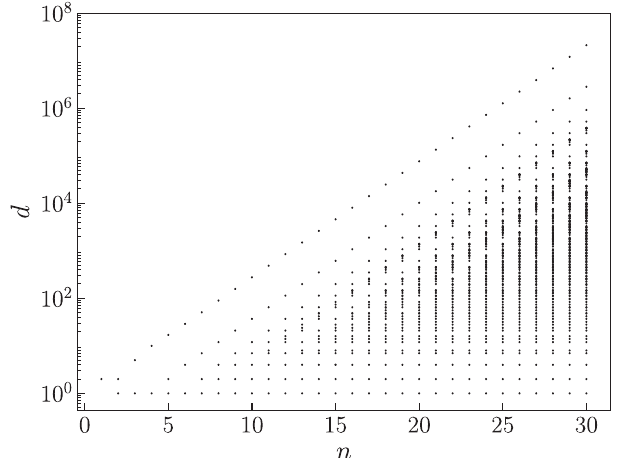
FIG. 5. The set of degeneracy values d for each n (logarithmic scale). (The range of n was selected to make individual points